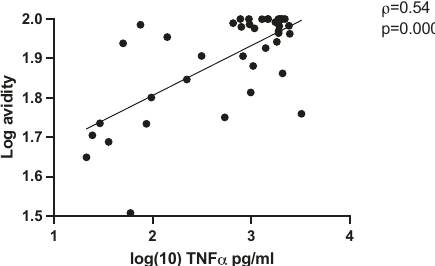
Fig. 4 gE-ADCC correlates with anti-gE antibody avidity. Data were derived from 40 participants who received RZV or ZVL and whose ADCC responses were measured in this study. Avidity measures were previously described 24 . TNF α concentrations and antibody avidity were log-transformed for this analysis to improve the distribution of the data points. The correlation coef fi cient and p value were calculated using Spearman correlations. Fig. 2). In contrast, VZV-ADCC did not correlate with the avidity of anti-VZV antibodies or neutralizing titers irrespective of the type of vaccine or age.